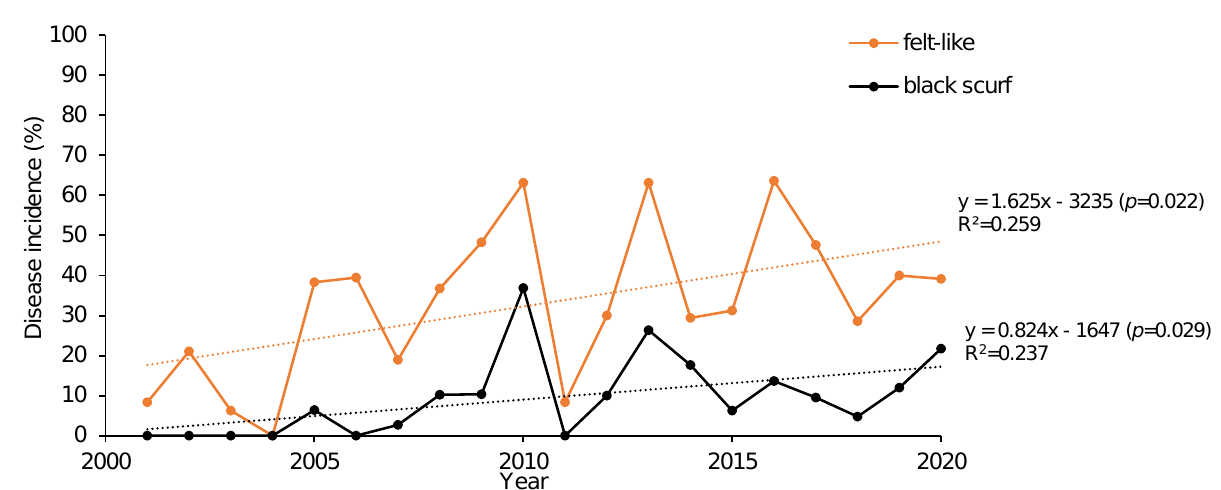
Figure 2. Disease incidence of Rhizoctonia symptoms in a total of 489 investigated carrot fields in Sweden during 2001– 2020. Symptoms are divided in felt-like fungal growth and black scurf.